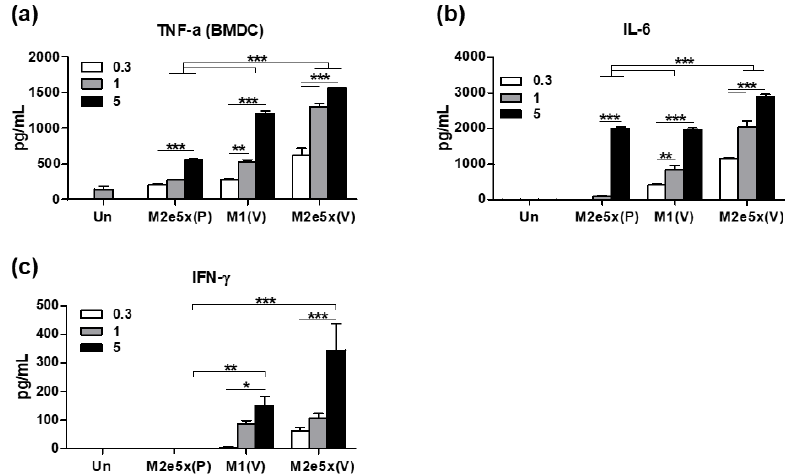
Figure 7. VLP effectively stimulates BMDCs in vitro to secrete cytokines. BMDCs were stimulated with M2e5x, M1 VLP, or protein (0.3, 1, 5 μg/mL) for 24 h. ( a – c ) The levels of cytokines ( a ) TNF-α, ( b )